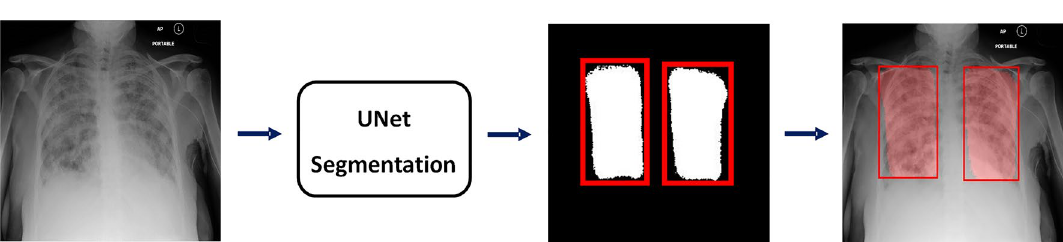
Figure 3. Block diagram of the CXR model based on UNet segmentation. After model training using UNet, we predicted the region of lung opacity pixel by pixel and then outlined the bounding boxes of the regions according to the segmentation